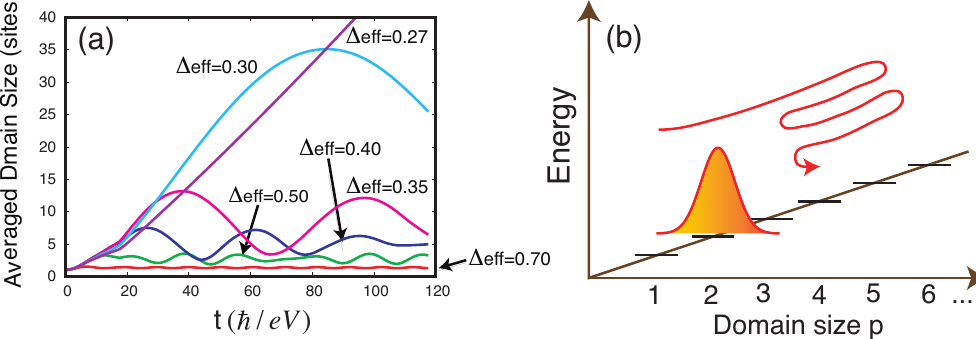
Figure 6. Dynamical behaviors in the domain model. All the results are obtained with ω c = 1.7 eV and τ d = 18 (¯ h /eV). ( a ) The time evolutions of the averaged domain size; ( b ) schematics of a real-space motion of a wave packet defined along the relative coordinate of the two domain